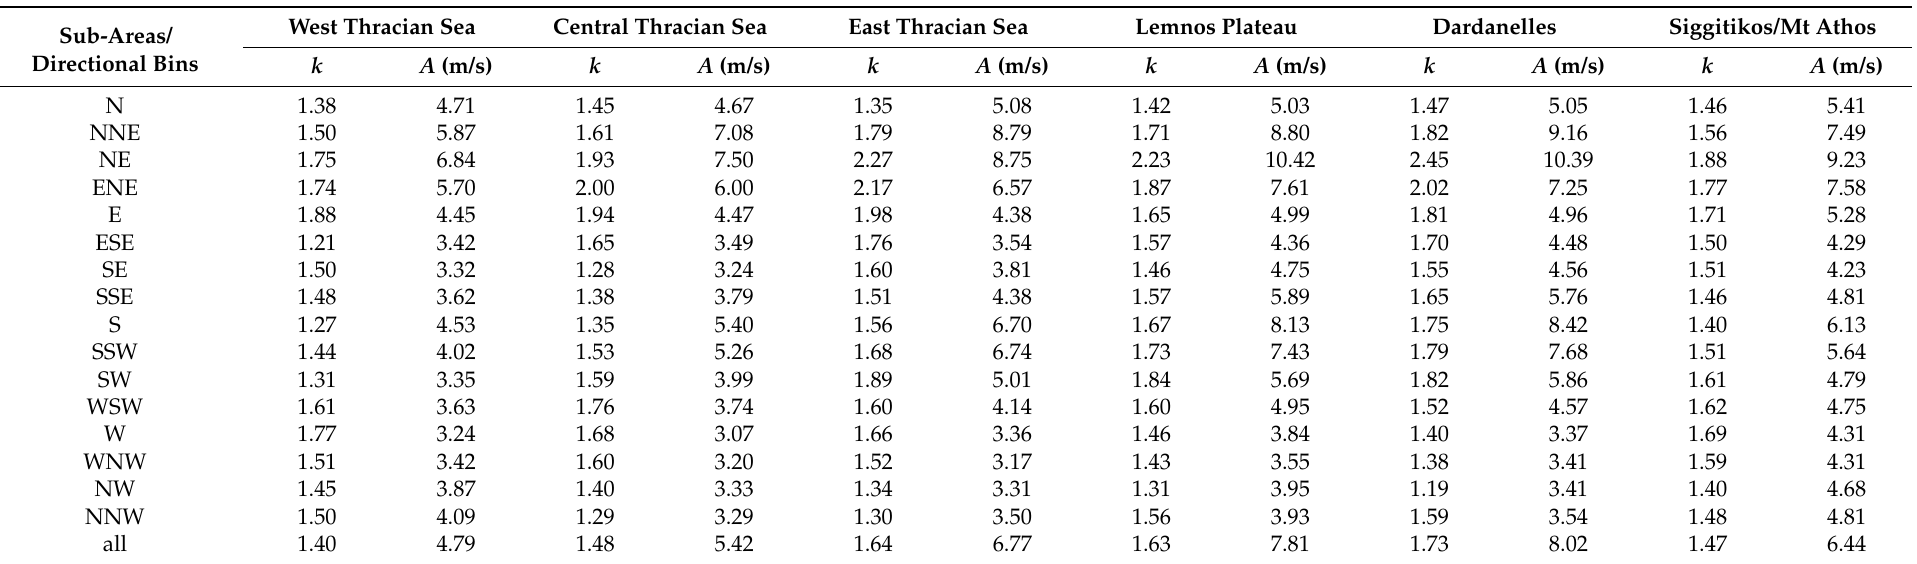
Table 2. Weibull probability density function parameters, per directional bin, at hub height for all